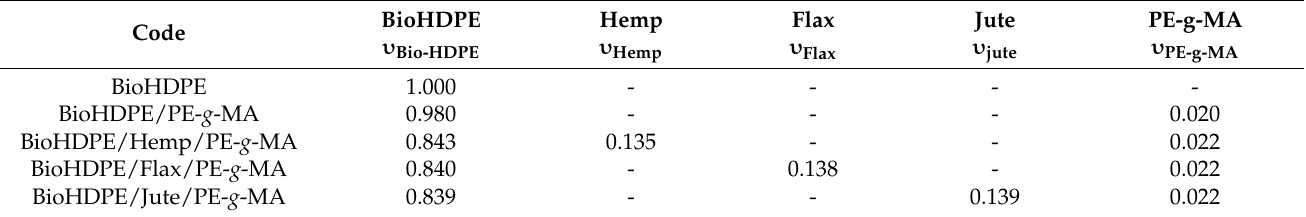
Table 1. Summary of compositions according to the volume fractions ( υ ) of BioHDPE, PE-g-MA and different natural fibers.